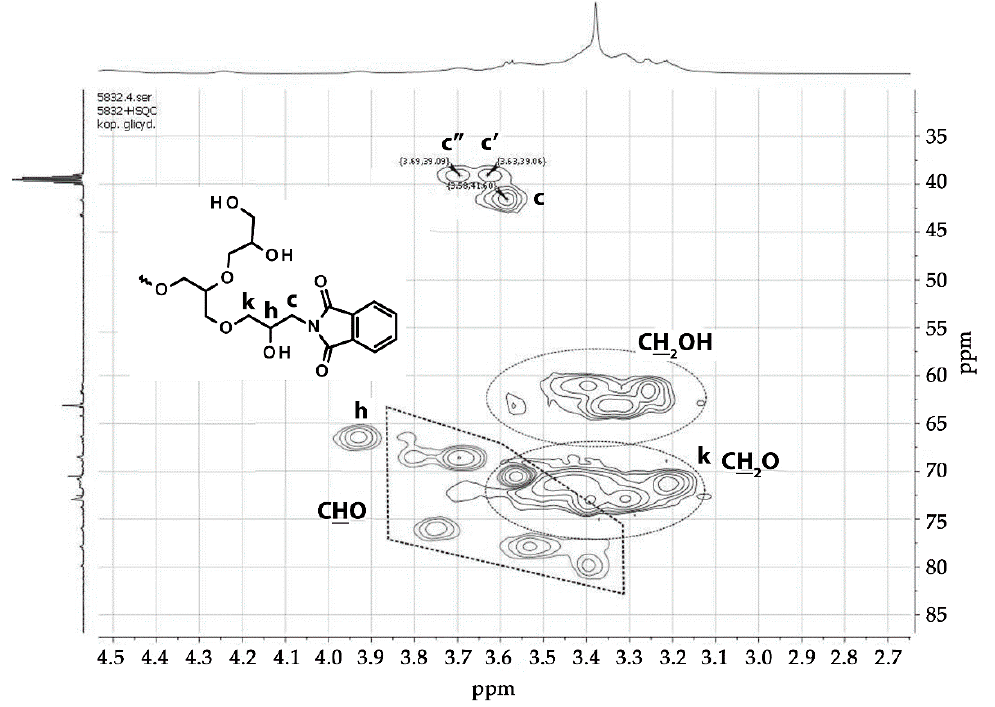
Figure 3. 1 H– 13 C HSQC NMR (DMSO–d 6 , 500 MHz) spectrum of 1a copolymer.